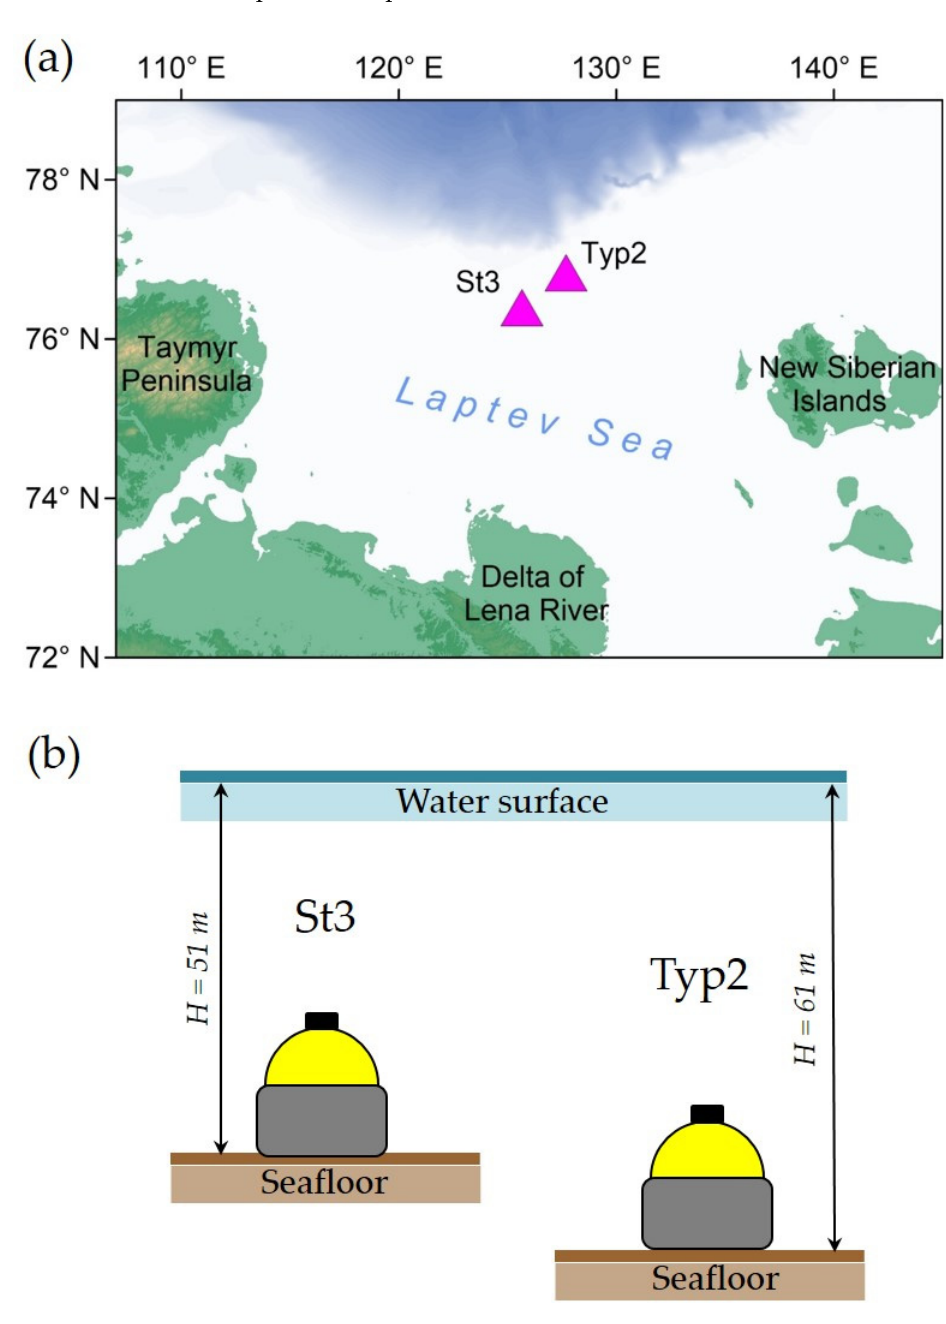
Figure 12. ( a )—OBS deployment sites on the outer shelf of the Laptev sea (operation time period: October 2019—January 2020); ( b )—schematic view of the OBS deployed in the Laptev sea with indication of sea depths.